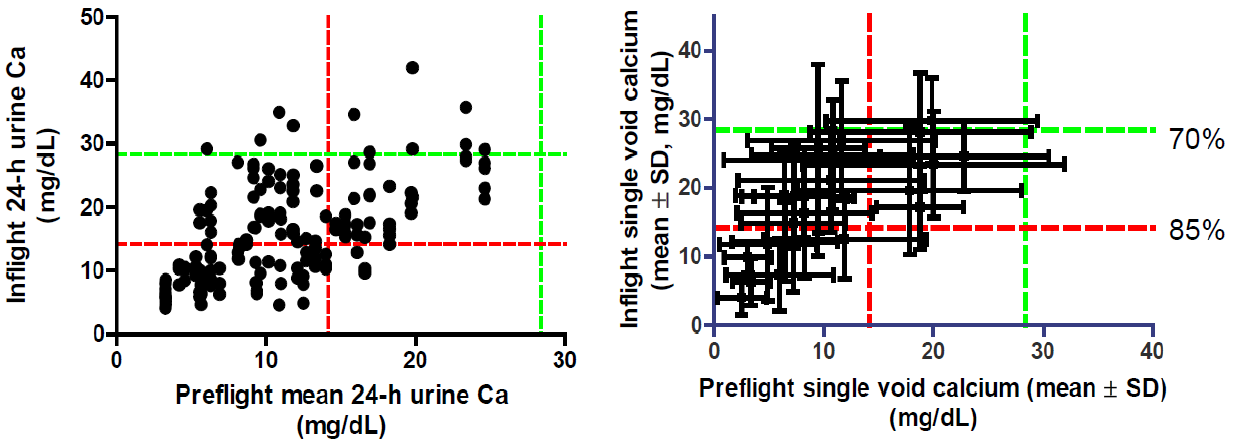
Figure 6. Relationships between preflight and in-flight urinary calcium concentrations. Left panel: Each symbol represents a 24-h urine collection, and on the x axis individual crewmember preflight data were averaged, with individual in-flight data points shown on the graph. Right panel: Each point reflects the average of all individual urine voids, and the error bars reflect one standard deviation of the data before flight (horizontal) or during flight (vertical). The green dashed lines represent calcium concentrations of 28.3 mg/dL, the expected calcium precipitation point for UPA water recovery at 70%, and the red dashed lines represent calcium concentrations of 14.2 mg/dL, the expected calcium precipitation point for UPA water recovery at